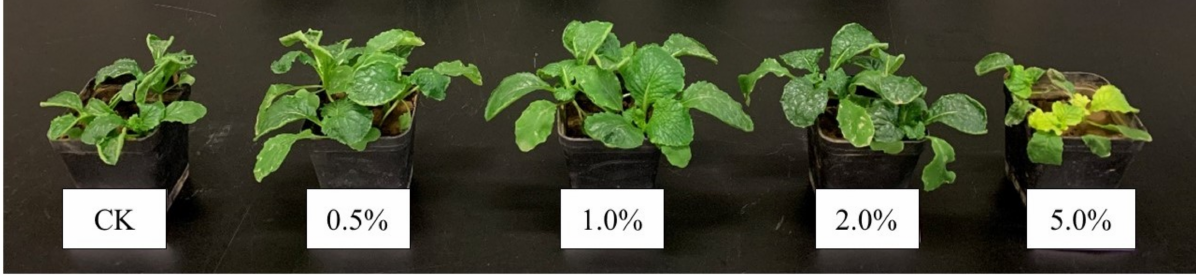
Figure 2. Effects of Ca-humic complex dosages on bok choy